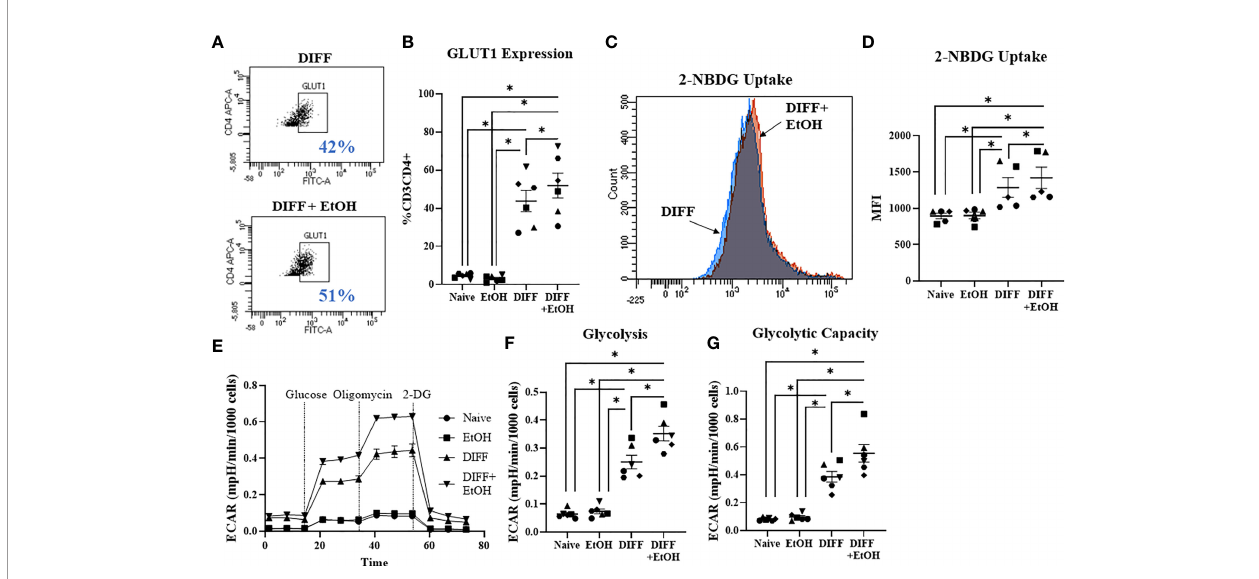
FIGURE 3 | Effect of ethanol on CD4 + T cell glucose metabolism. (A) Representative FACS plots of GLUT1 expression in DIFF and DIFF + EtOH CD4 + T cells. (B) Ethanol increased CD4 + T cell GLUT1 expression. (C) Representative FACS histograms of 2-NBDG uptake in DIFF and DIFF + EtOH CD4 + T cells. (D) Ethanol increased glucose uptake within differentiated CD4 + T cells. (E) All experimental groups were analyzed using the Glycolytic Stress test. Ethanol increased glycolysis (F) and glycolytic capacity (G) within differentiated groups. MFI = mean fl uorescent intensity, 2-NBDG = 2-Deoxy-2-[(7-nitro-2,1,3-benzoxadiazol-4-yl)amino]-D- glucose, ECAR = extracellular acidi fi cation rate, Naïve = undifferentiated and no ethanol treatment, EtOH = undifferentiated and ethanol-treated, DIFF = differentiated and no ethanol treatment, and DIFF + EtOH = differentiated and ethanol-treated. Data represents average values using CD4 + T cells from 6 donors expressed as mean ± SEM. Signi fi cant differences (p<0.05) were determined by repeated measures 2-way ANOVA. *p ≤ 0.05.